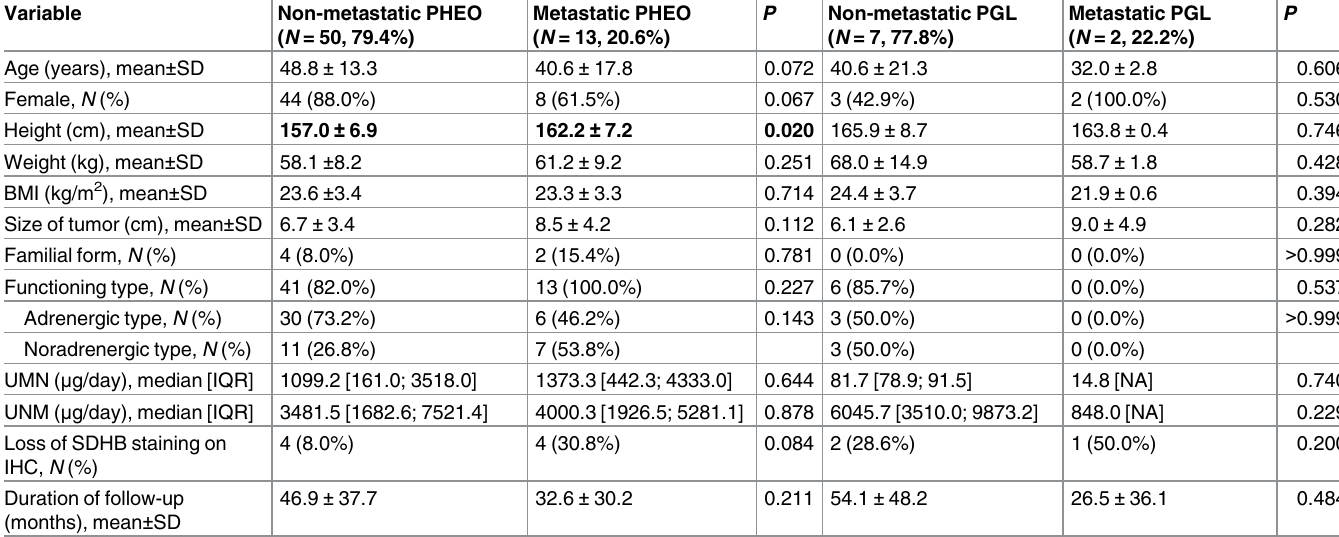
Table 3. Baseline characteristics of the 72 PPGL patients according to the occurrence of metastasisby PHEO or